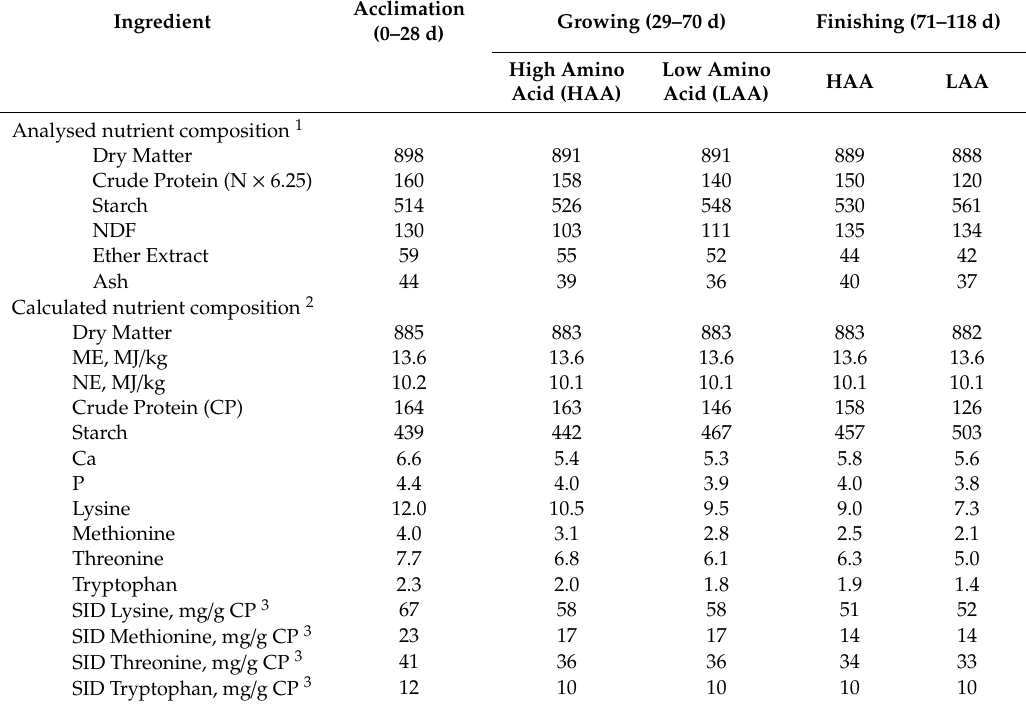
Table 2. Chemical composition (g / kg as fed) and energy content of the experimental